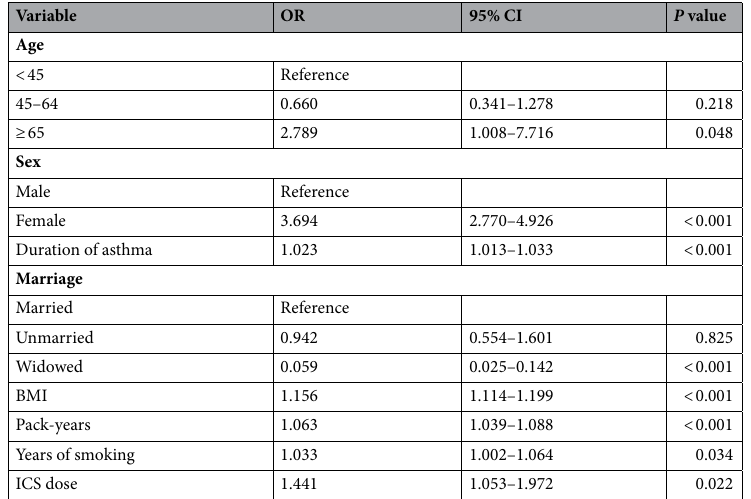
Table 3. Multivariate logistic regression analysis of factors associated with smoking cessation based on sociodemographic characteristics. Values were expressed as odds ratio (OR) and 95% confidence interval (CI). Factors associated with smoking cessation were determined by multivariate logistic regression analysis. Multivariate analysis was adjusted for ACT, FEV 1 , FEV 1 /FVC, age, sex, marriage, BMI, Pack-years and Years of smoking. P < 0.05 was considered statistically significant. BMI body mass index, 95% CI 95% confidence interval, ICS inhaled corticosteroids, OR odds